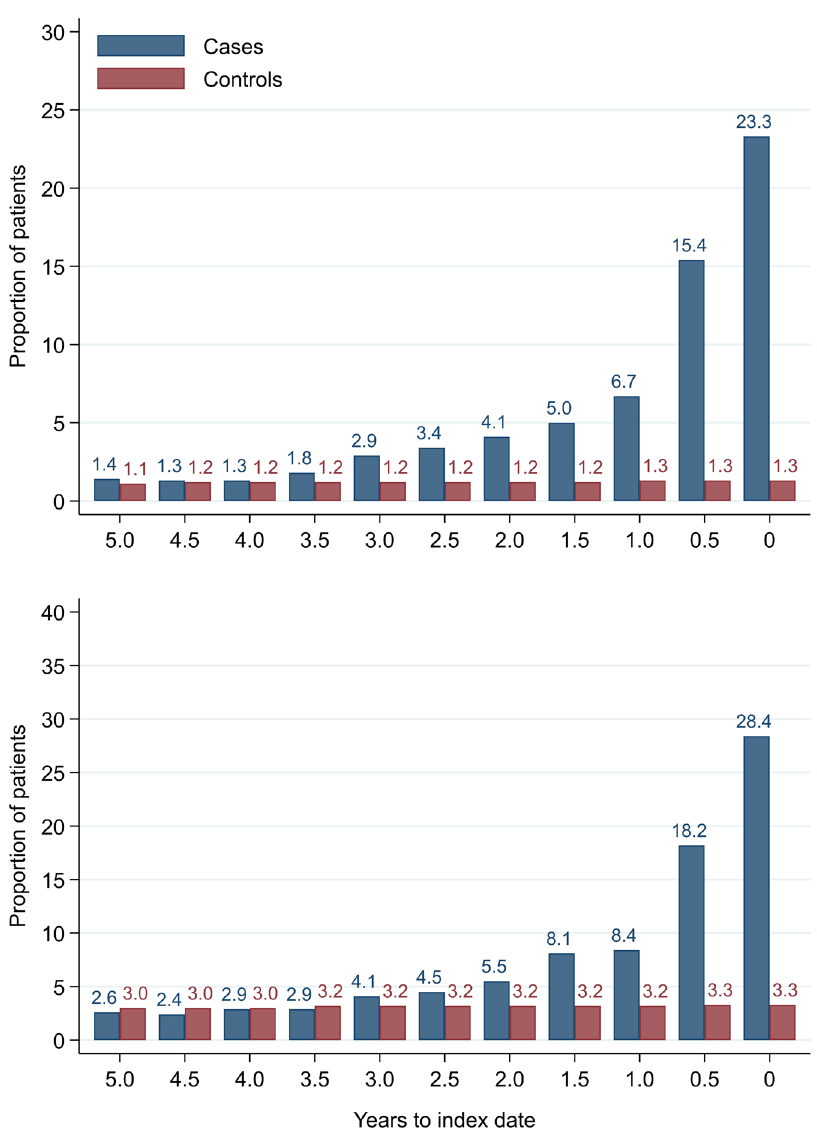
Figure 20. Microcytic anaemia prevalence over six-monthly (+/- 3 months) time band. Legend: males (top) and females (bottom).